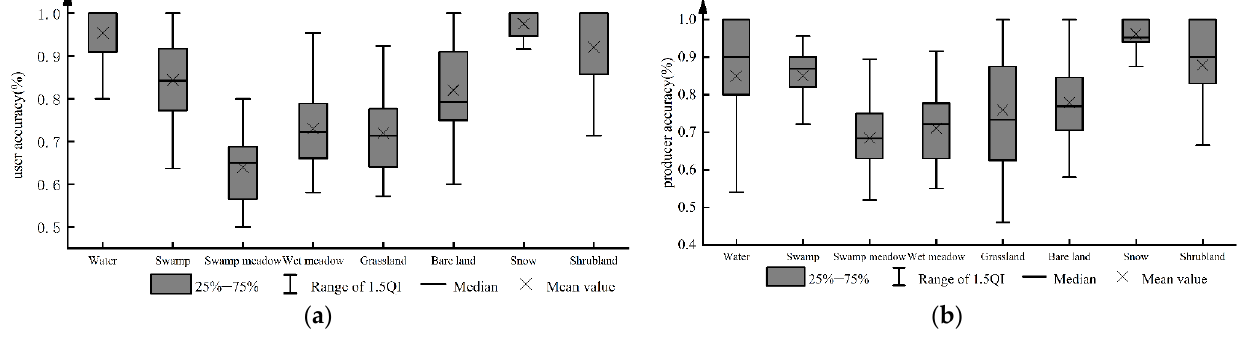
Figure 4. User accuracy and producer accuracy for each class. ( a ) user accuracy, ( b ) producer accuracy.